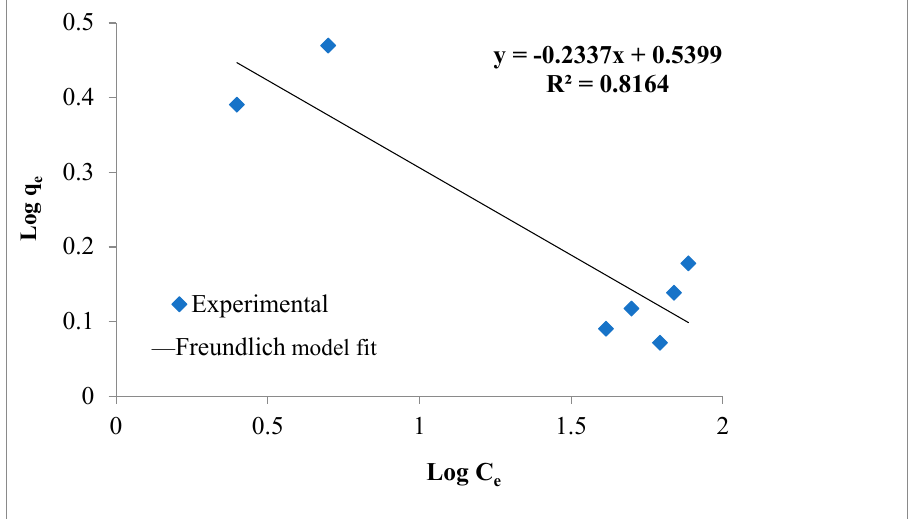
Figure 11. Freundlich adsorption isotherm model for 2,4-D on TMS. Table 4. Isotherm variables for 2,4-D adsorption on TMS.